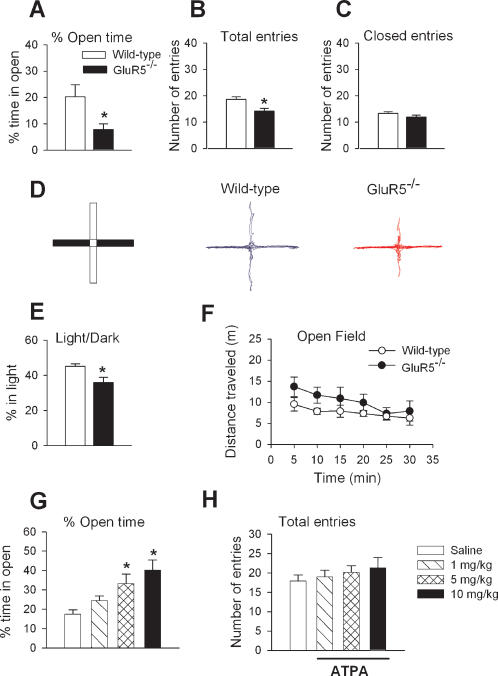
Anxiety-like behavior in GluR5−/− mice. (A) GluR5−/− mice (n = 17) spent significantly less time in the open arms of the EPM compared to wild-type mice (n = 10). (B) The total number of arm entries (open+closed) was decreased in GluR5−/− mice but there was no difference in closed arm entries (C) between genotypes. (D) From left to right: Diagram of the EPM, filled boxes = closed arms, open boxes = open arms; representative traces showing the movement of wild-type and GluR5−/− mice in the EPM for 5 mins. (E) GluR5−/− mice (n = 8) spent significantly less time in the light half of the chamber compared to wild-type mice (n = 6). (F) No significant difference was detected in the distance traveled in the open field. * P<0.05. (G) While open arm exploration was not affected by 1 mg/kg ATPA (n = 5), 5.0 mg/kg (n = 7) and 10.0 mg/kg (n = 10) ATPA significantly increased the time spent in the open arms compared to mice receiving saline (n = 9). (H) There was no difference in the number of total arm entries across treatment groups.